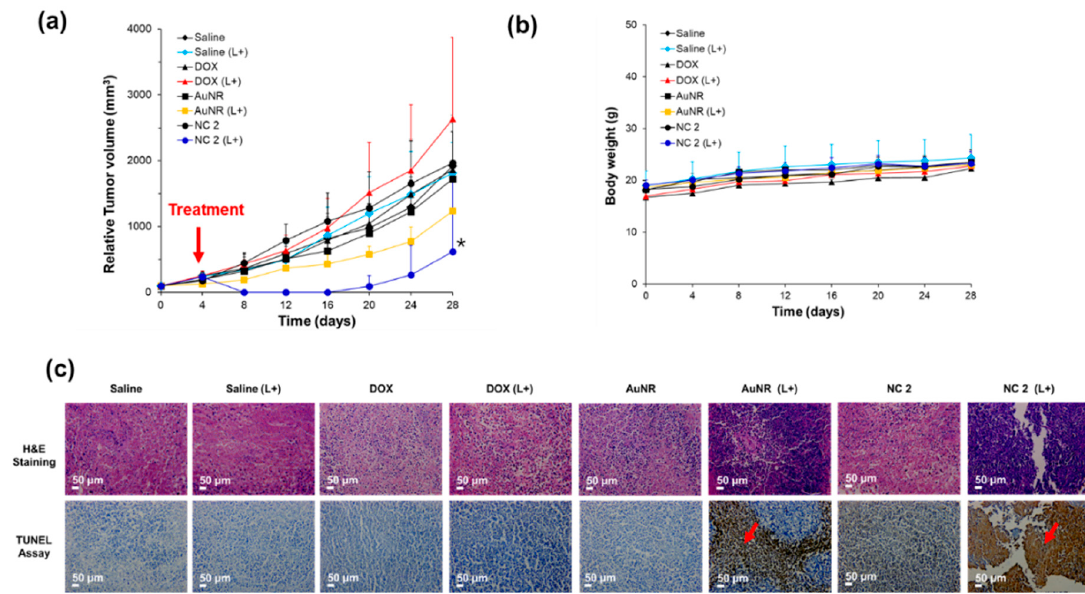
Figure 5. In vivo photothermal effect of NC 2: ( a ) tumor efficacy, ( b ) tumor toxicity, and ( c ) histologic study using Haemotoxylin and Eosin (H&E) staining and a Tunnel assay of tumor tissues on Day 28 (* indicates tumor relapse, n = 1). Red arrow indicates the treatment point of therapeutic assay to all experimental groups.